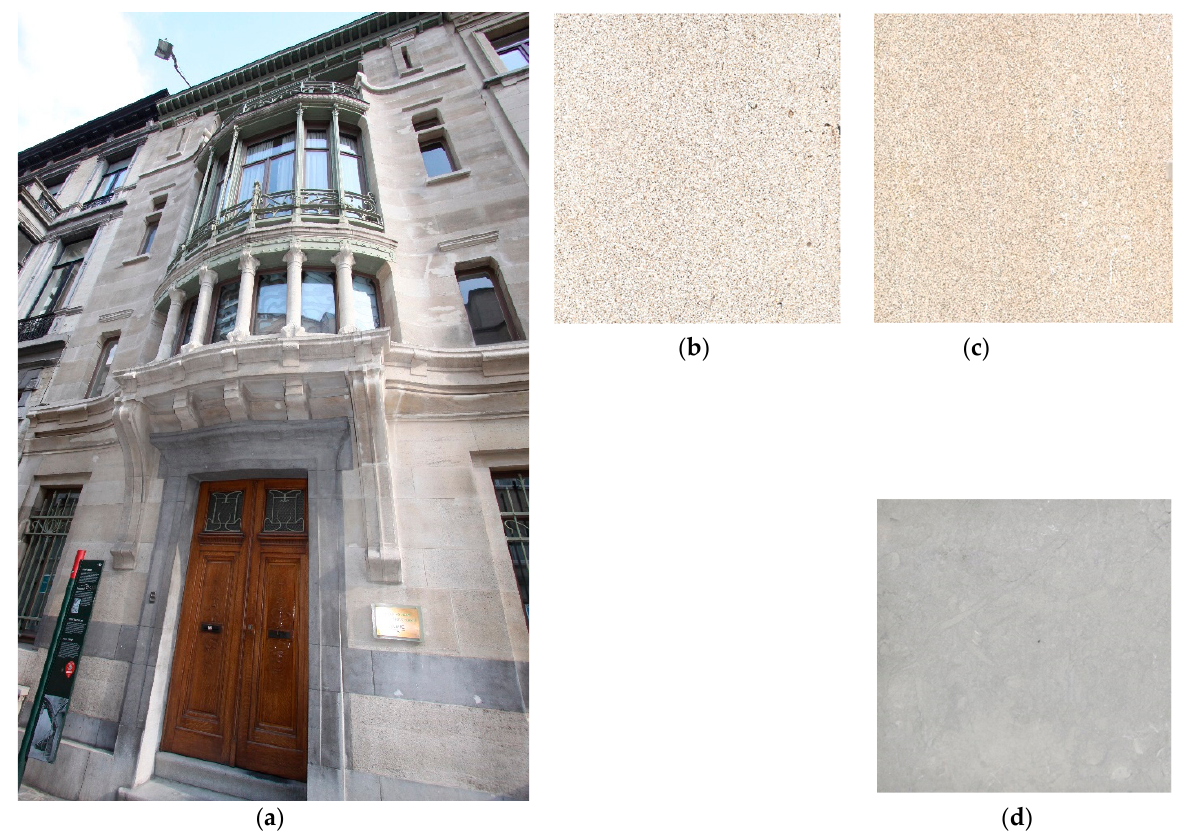
Figure 7. The colors of the Tassel House façade: ( a ) The Tassel House façade; ( b ) the Savonnières Stone ©ROCAMAT; ( c ) the Euville Stone ©ROCAMAT; ( d ) the Ritz Bleu Stone ©ROCAMAT.